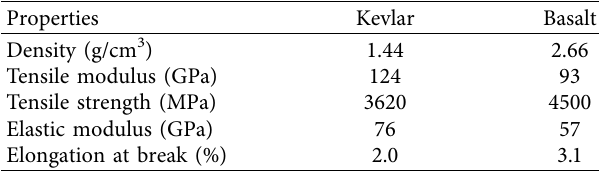
Table 1: Properties of Kevlar and